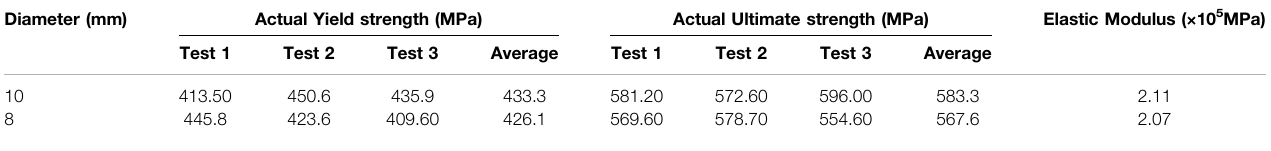
TABLE 3 | Rebar performance testing parameter.